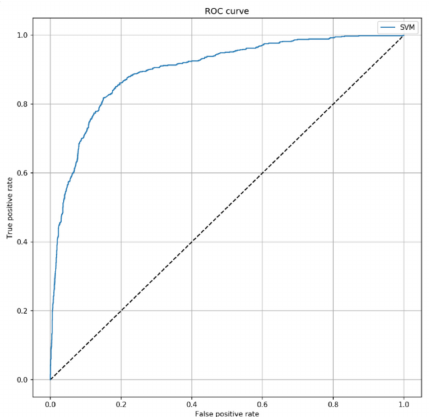
Figure 3. ROC curve of the SVM algorithm to predict 7-day mortality, by excluding infected